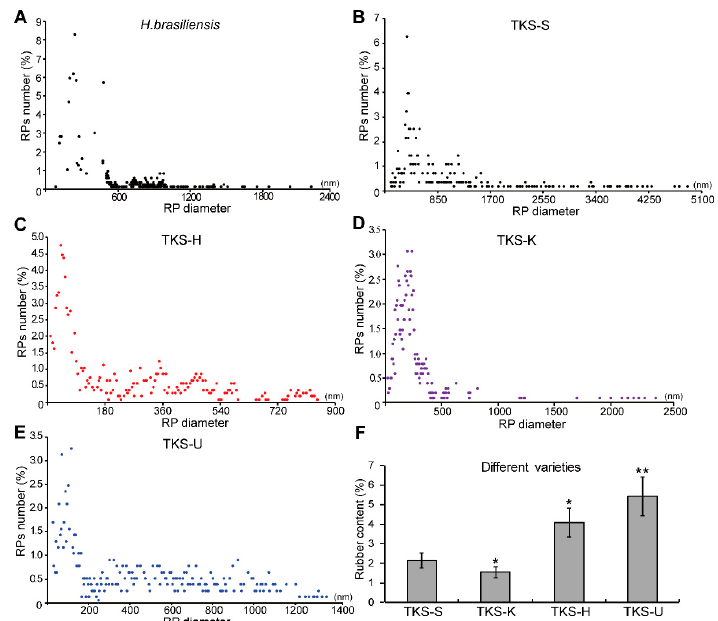
Figure 6. Statical analysis of rubber particle accumulation patterns and determination of rubber content in different rubber-producing plants. The percentages of different sized rubber particles in H. brasiliensis ( A ) and different T. kok-saghyz varieties ( B – E ) were calculated based on their diameters. The content of natural rubber in the four TKS varieties was further determined, and the highest rubber content was obtained from the old roots of TKS-U variety ( F ).